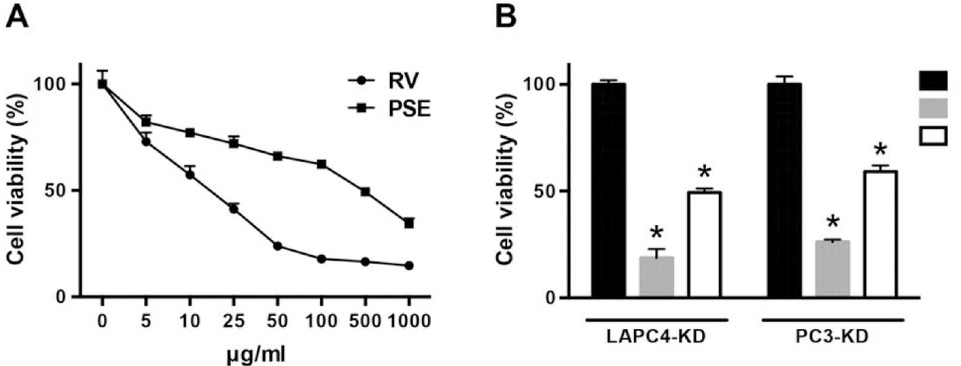
Fig 2. Resveratrol (RV) and peanut stem extract (PSE) inhibit proliferation of radioresistant prostate cancer. (A) LAPC4-KD were treated with RV or PSE at indicatedconcentrations (0–1000 μ g/mL) for 48 h. (B) LAPC4-KDand PC3-KD cells were treated with RV or PSE (25 or 500 μ g/mL, respectively)for 48 h. Cell viability was assessedusing the 3-(4,5-dimethylthiazol-2-yl)- 2,5-diphenyltetrazoliumbromide(MTT) assay. Statistical significancewas evaluatedusing Student’s t -test ( * , P <